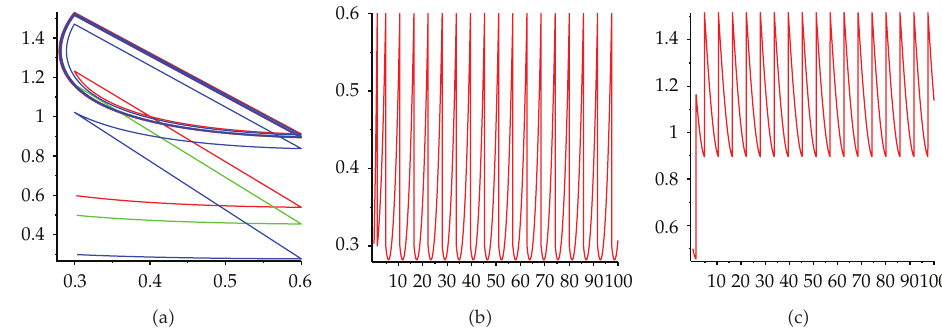
Figure 11: The time series and phase diagram for system (cid:4) 1.4 (cid:5) starting from initial value (cid:4) 0 . 3 , 0 . 1 (cid:5) (cid:4) blue (cid:5) , (cid:4) 0 . 3 , 0 . 5 (cid:5) (cid:4) green (cid:5) , (cid:4) 0 . 3 , 0 . 6 (cid:5) (cid:4) red (cid:5) , α (cid:8) 0 . 5 , β (cid:8) 0 . 2 , q (cid:8) 0 . 8 , h (cid:8) 0 . 6 , x